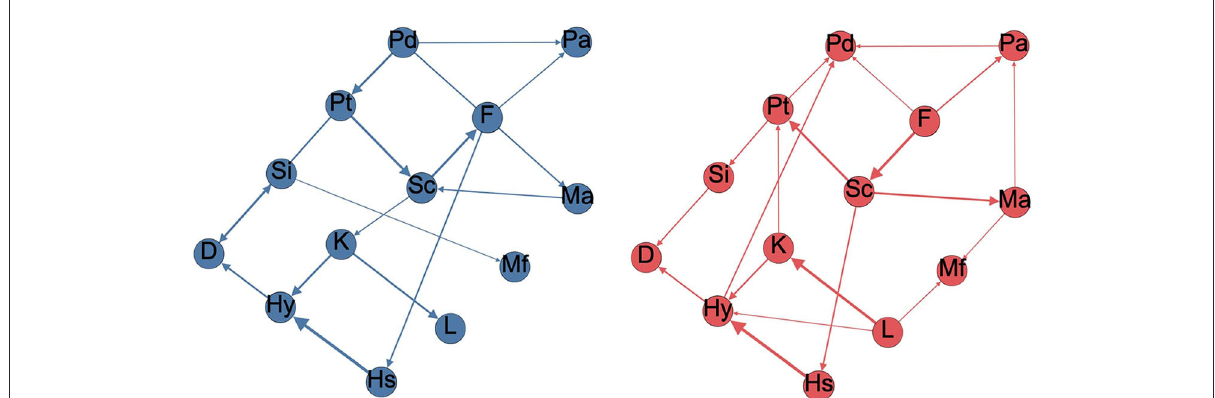
FIGURE1 Minnesota Multiphasic Personality Inventory (MMPI)-2 scales Bayesian network for healthy participants (left) and patients with schizophrenia (right). The thickness of the arcs is proportional to the BIC value, D, Depression; F Infrequency; Hs, Hypochondriasis; Hy, Hysteria; K, Defensiveness; L, Lie; Ma, Hypomania; Mf, Masculine feminine; Pa, Paranoia; Pd, Psychopathic deviate; Pt, Psychasthenia; Sc, Schizophrenia; Si, Social